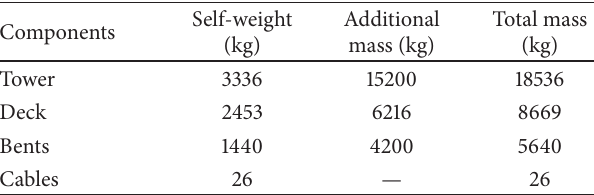
Table 2: Self-weight and additional masses of the model. Table 3: Test results of microconcrete